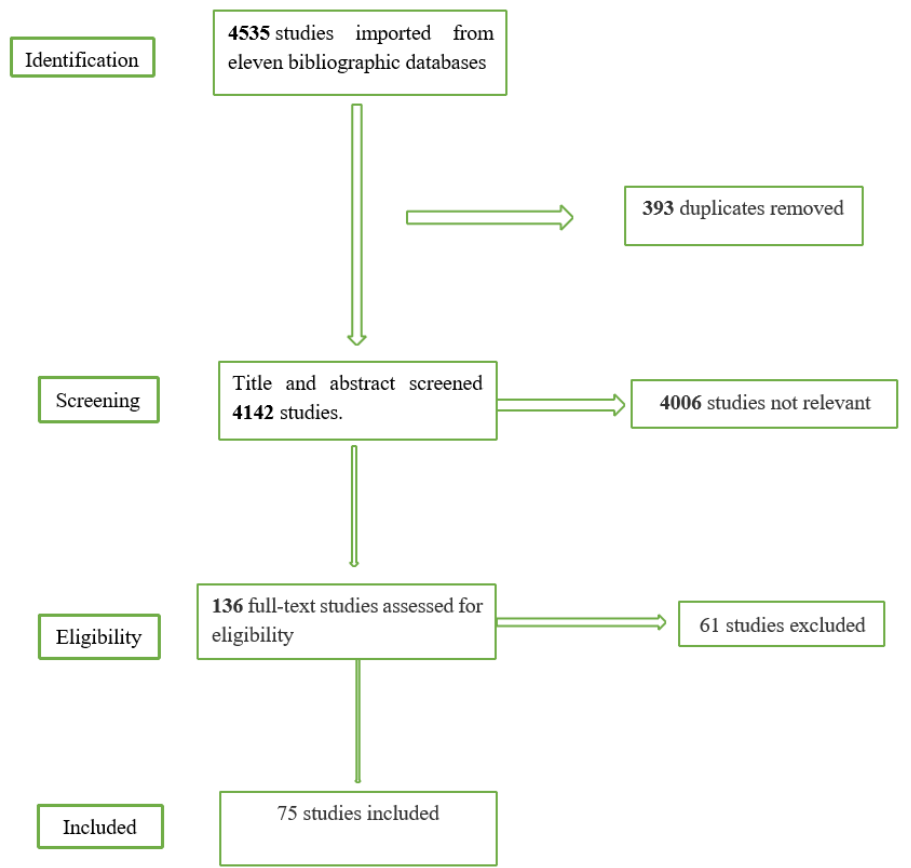
Figure 1. PRISMA flow chart.